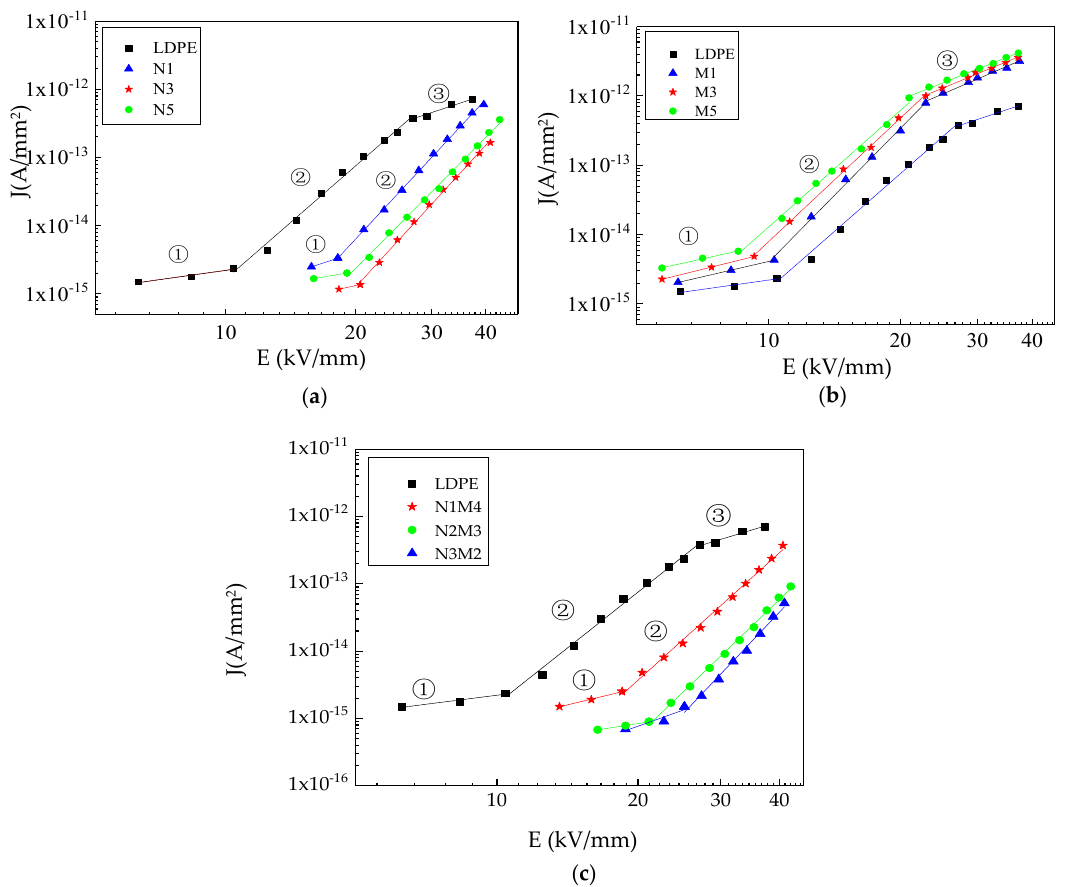
Figure 5. Relationship between conductivity current and field strength of different samples: ( a ) Nano ZnO/LDPE composites; ( b ) micro ZnO/LDPE composites; ( c ) micro-nano ZnO/LDPE composites.